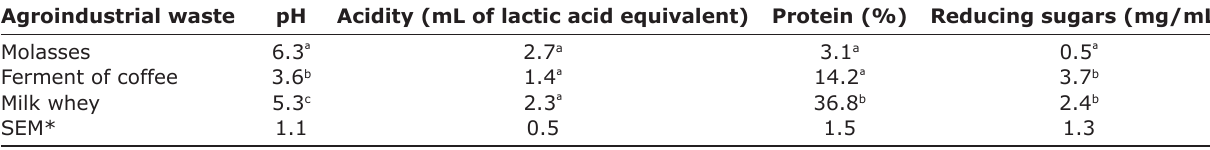
Table-2: Physico-chemical characterization of agroindustrial waste. Agroindustrial